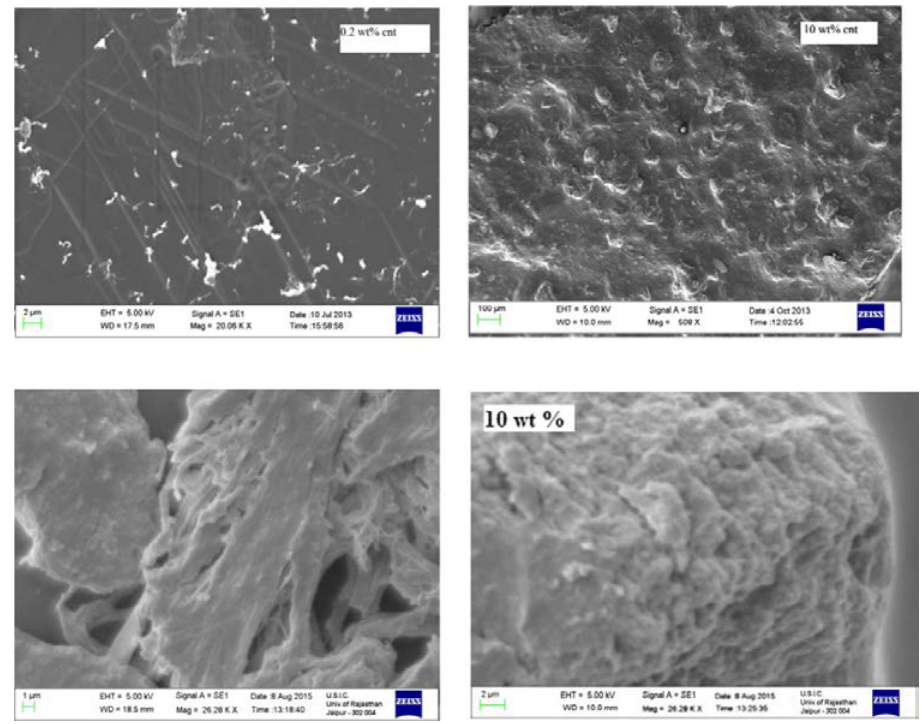
Figure 2. SEM micrographs representing miscibility of MWNT/PMMA with the increasing content of MWNT. Reprinted from [37] with the permission of Materials Research Express.